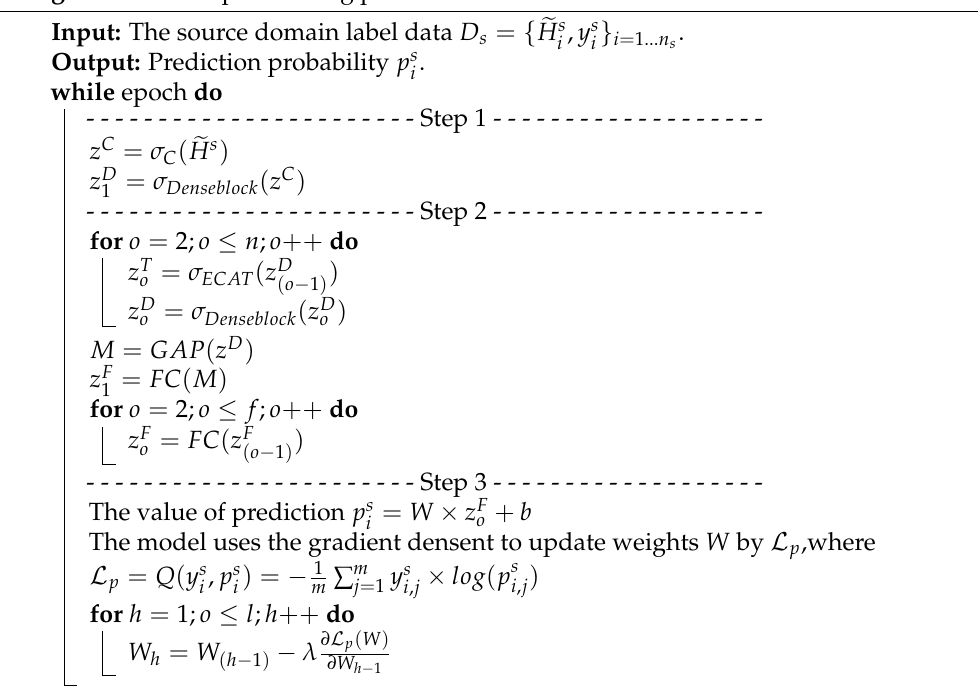
Figure 10. ( a ) The attention-based DenseNet (AD) model. ( b ) Illustration of denseblock with a 1 × 1 convolution layer and a 3 × 3 convolution layer. ( c ) Illustration of transition block with a 1 × 1 convolution layer, a 2 × 2 pooling layer, and an ECA structure. Algorithm 1: The pre-training